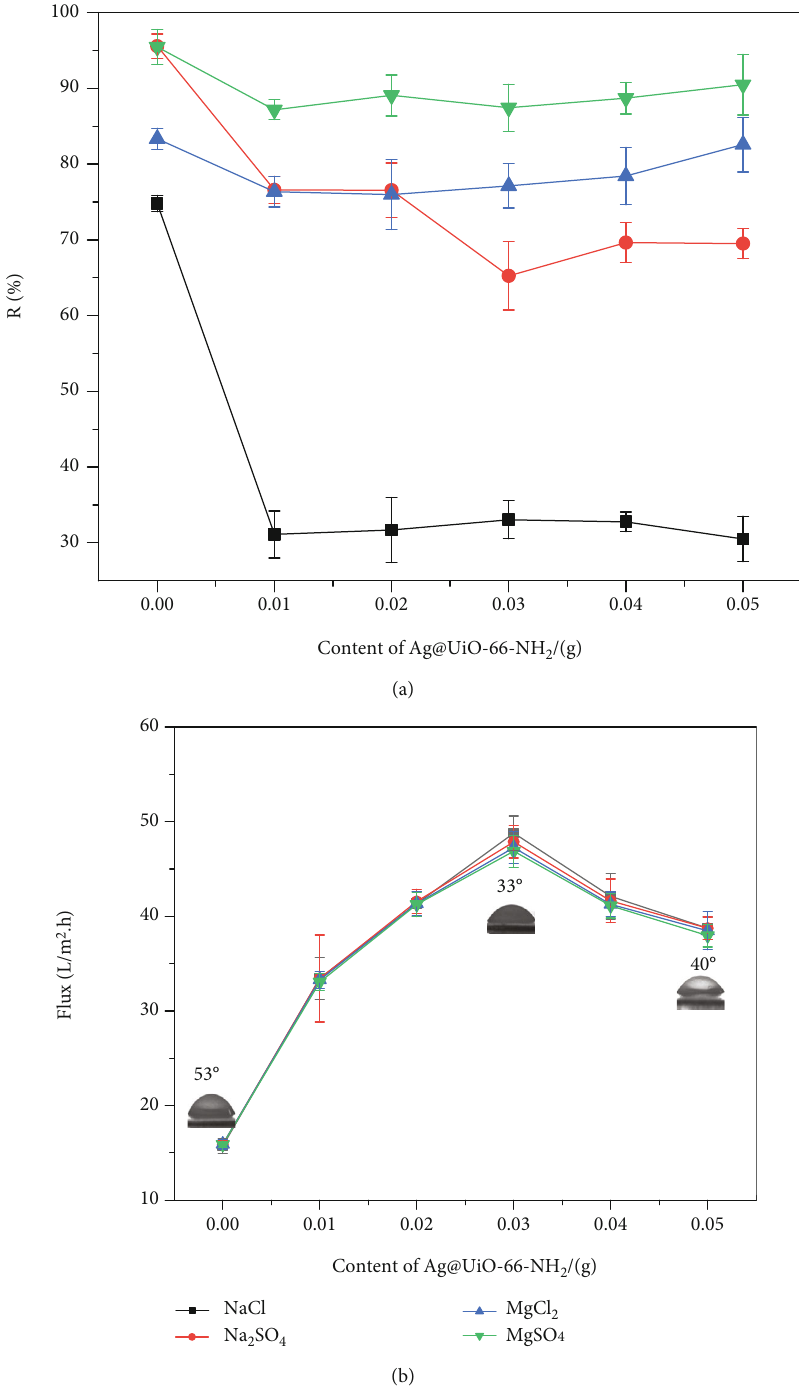
Figure 9: Separation performance of Ag@UiO-66-NH